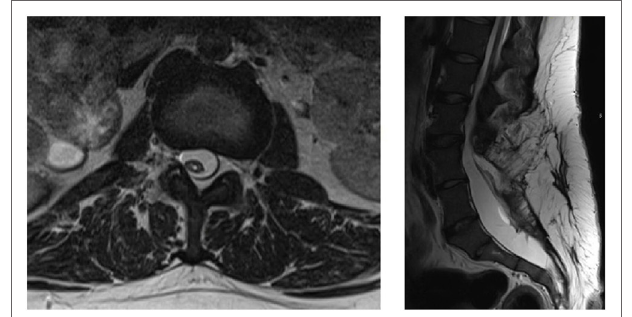
FIgURe 1 | Axial and sagittal T2 lumbar MRI showing postsurgical changes from L3-L5 with neural elements present to the sacrum with an associated